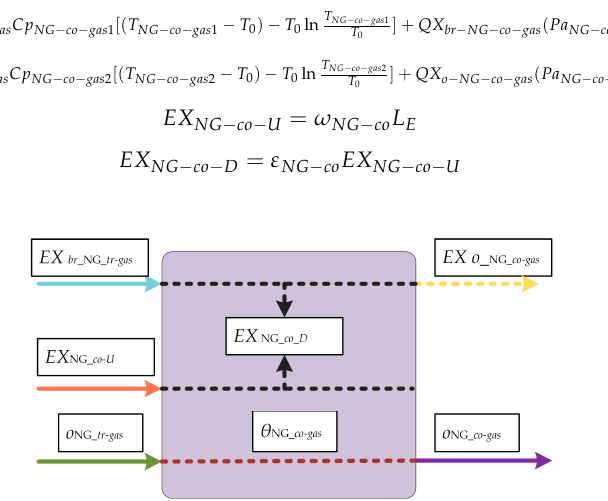
Figure A4. Process flowsheets of NG-tr .